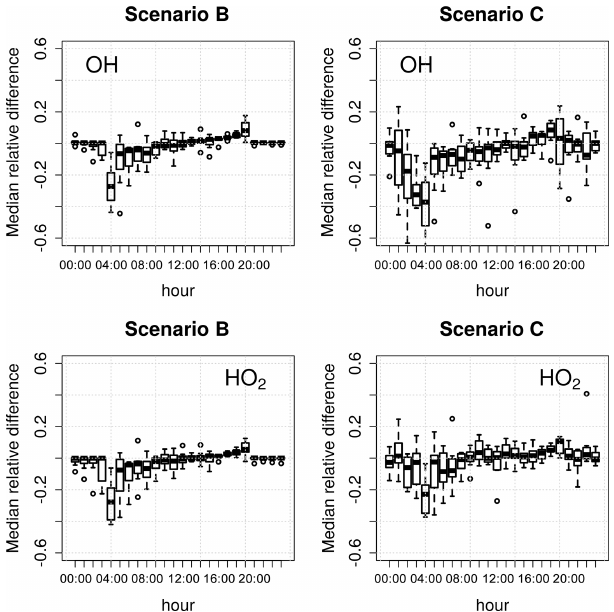
Figure 2. Diurnal distributions of the relative differences in the cal- culated concentrations of OH and HO 2 in scenarios B and C com- pared to scenario A (Table 1) over a 9d model run. The box-and- whiskers plots show the medians and the 1st and 3rd quartiles, while the open circles indicate the